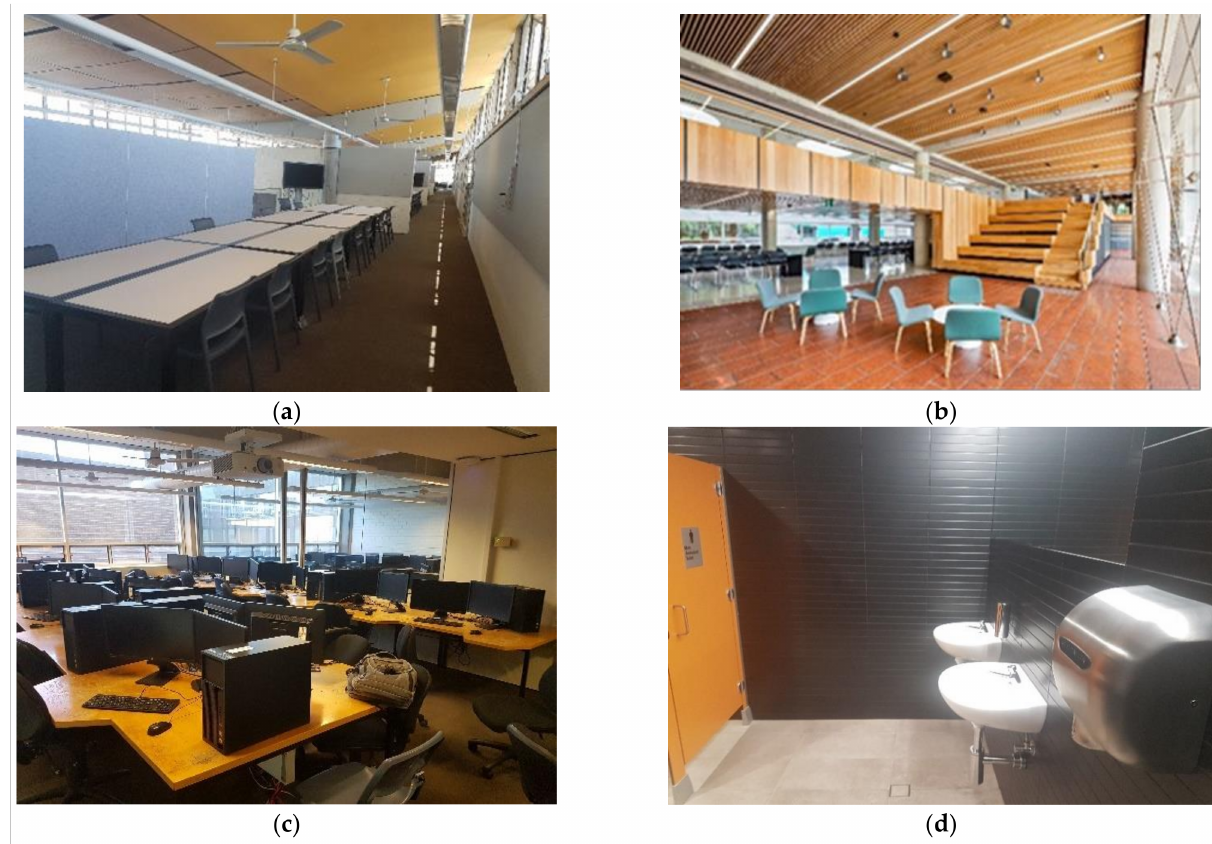
Figure 3. ( a ) Study spaces and classroom level 6; ( b ) newly renovated learning spaces; ( c ) computer lab at level 3; ( d ) toilet at